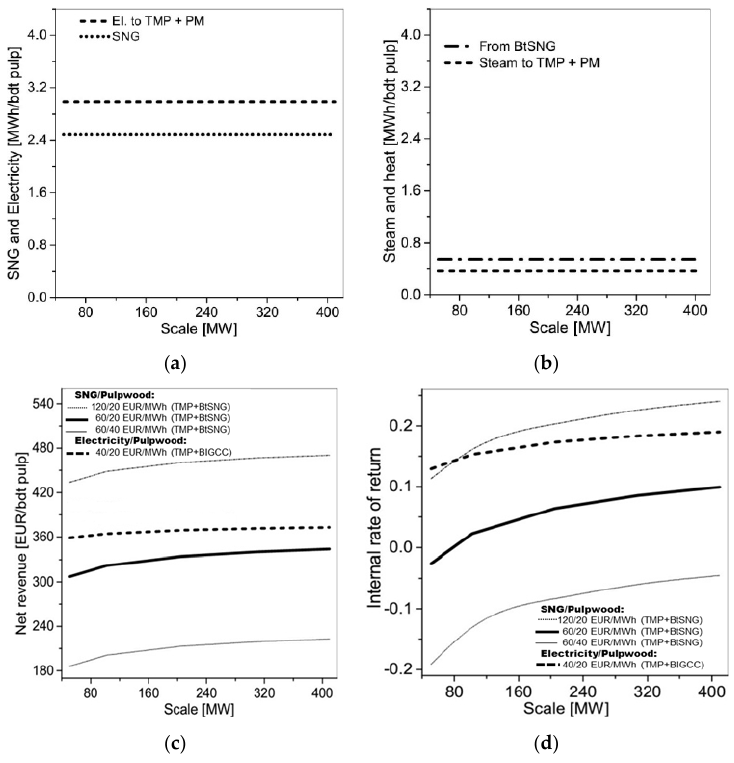
Figure 6. Effect of the BtSNG plant scale as the biomass thermal input.